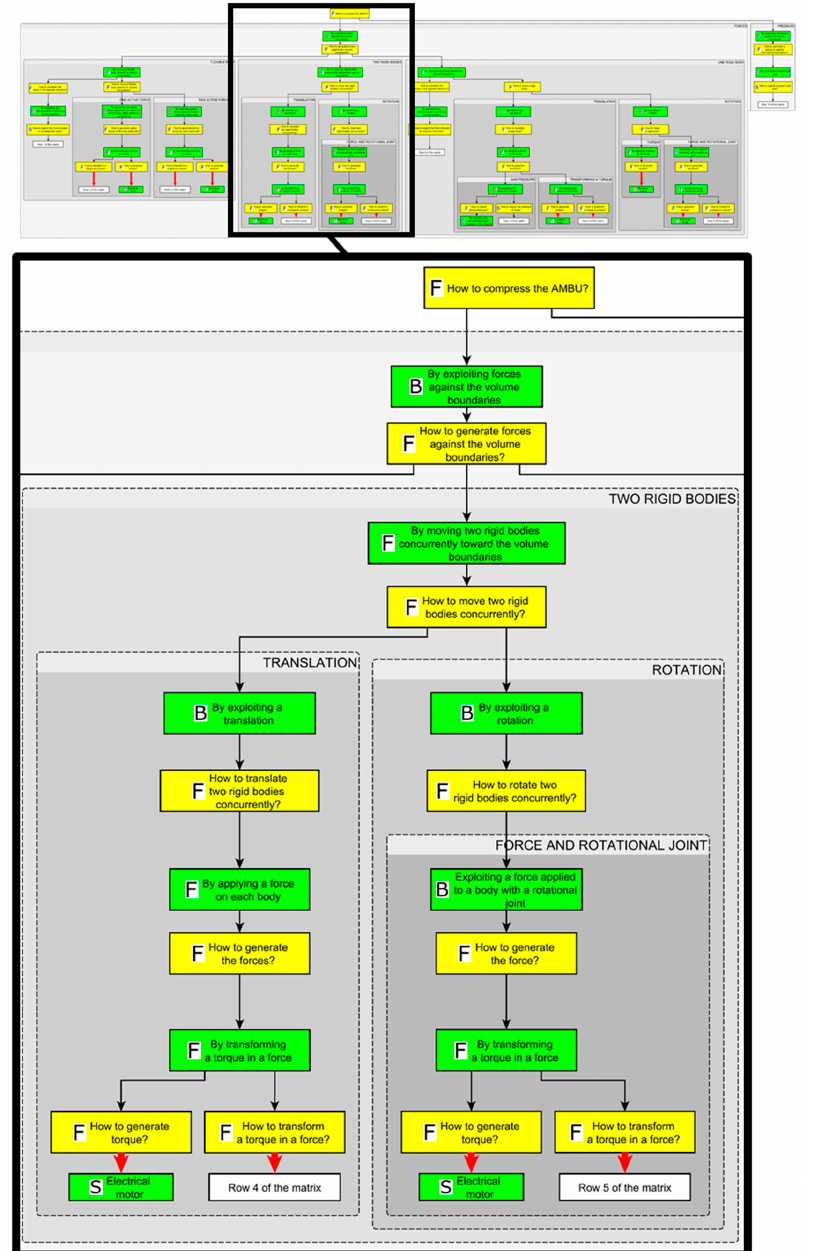
Figure 6. Overview and detailed excerpt of the simplified PSN obtained to represent the ventilators reviewed in [17]. Please see the freely available dataset [71] for a full-scale view.